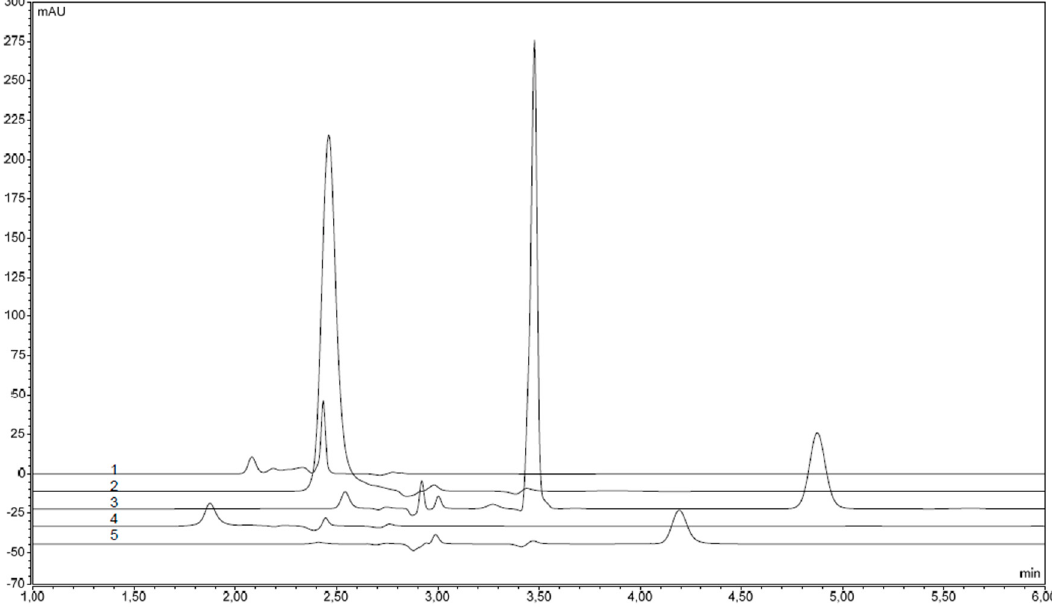
Figure 3. Chromatograms of coloring standards: 1—Ponceau 4R (E124); 2—Tartrazine (E102); 3—Quinoline Yellow (E104); 4—Carmine (E120); 5—Sunset Yellow (E110).